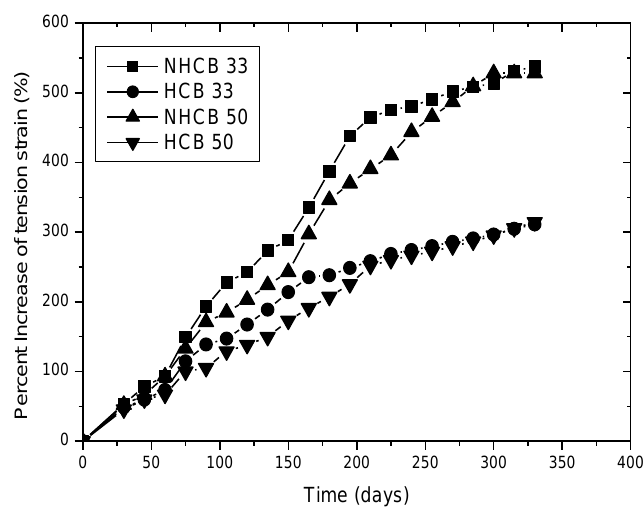
Figure 9. Percentage variation of longitudinal concrete tensional strains.